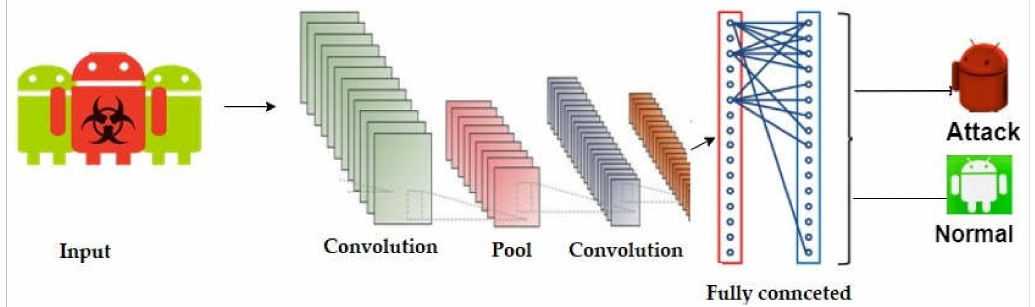
Figure 6. Structure of the CNN